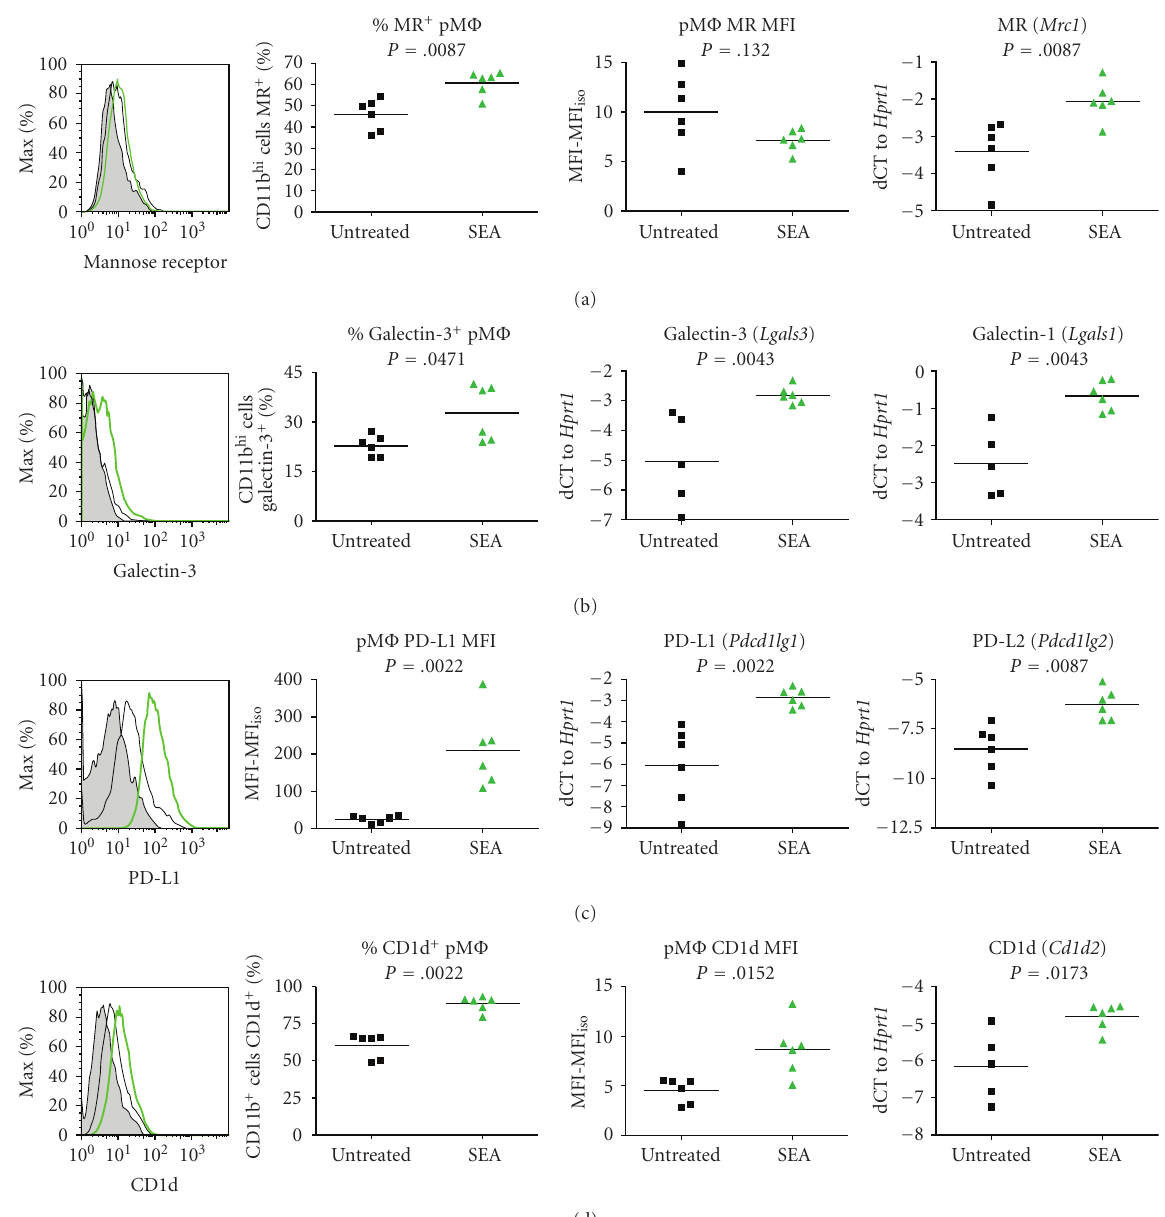
Figure 3: Schistosome antigens alternatively activate M Φ s in vivo. CD11b + peritoneal M Φ s upregulate surface expression of (a) mannose receptor, (b) galectin-3, (c) PD-L1, and (d) CD1d, with accompanying increases in mRNA levels in whole PECs. Data from six mice per group treated and analyzed as in Figure 2 are shown. Statistical analysis by Mann Whitney U test,